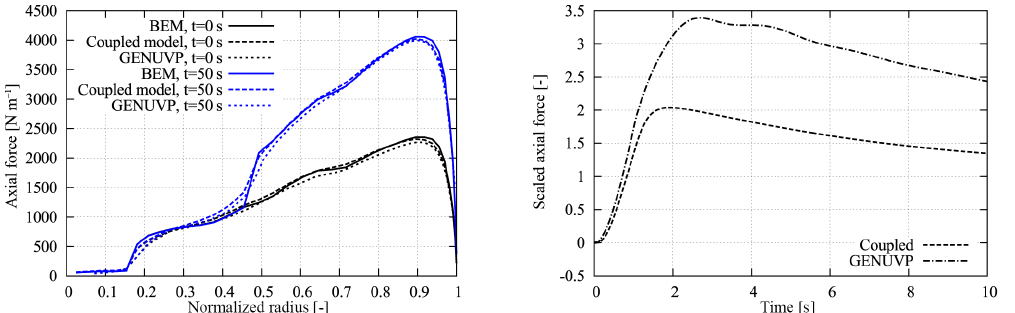
Figure 15. Left plot: force distribution before the partial pitch step and 50s after. Right plot: time history of the axial force comparing coupled model and GENUVP at 21.6m radius (34.3% rotor radius). The BEM gives a constant force.